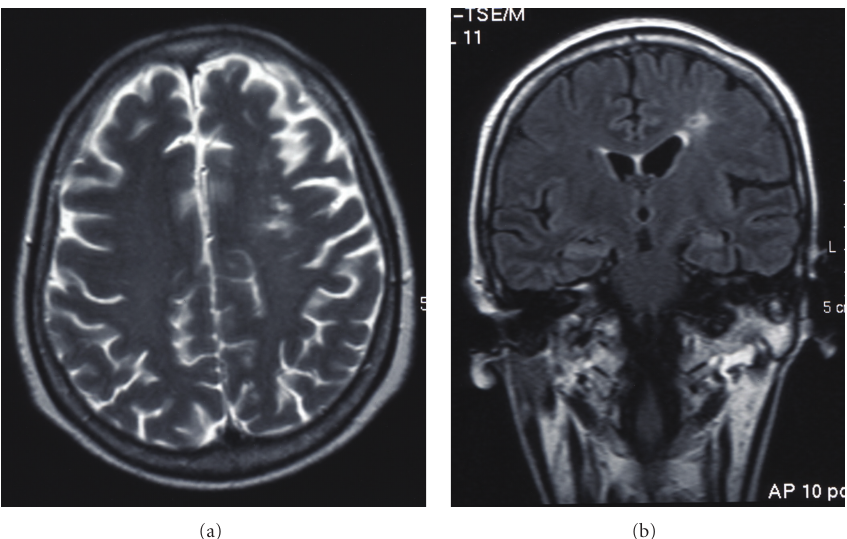
Figure 1: Preoperative magnetic resonance imaging axial T2-weighted image (a) and coronal FLAIR image (b). Cerebral infarction of the left fronto-parietal watershed area was noted.